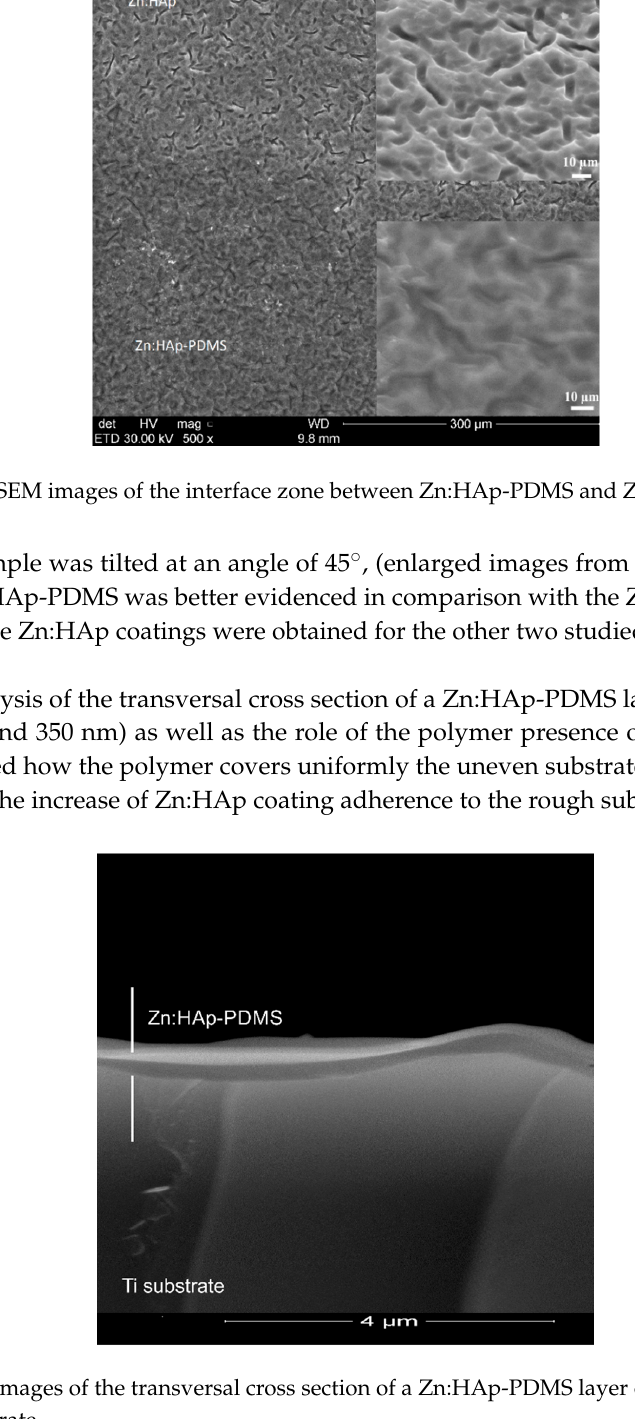
Figure 5. SEM images of the interface zone between HAp-PDMS (darker zone) and HAp (lighter zone) for different magnification: ( a ) ×2000; ( b ) ×10,000.